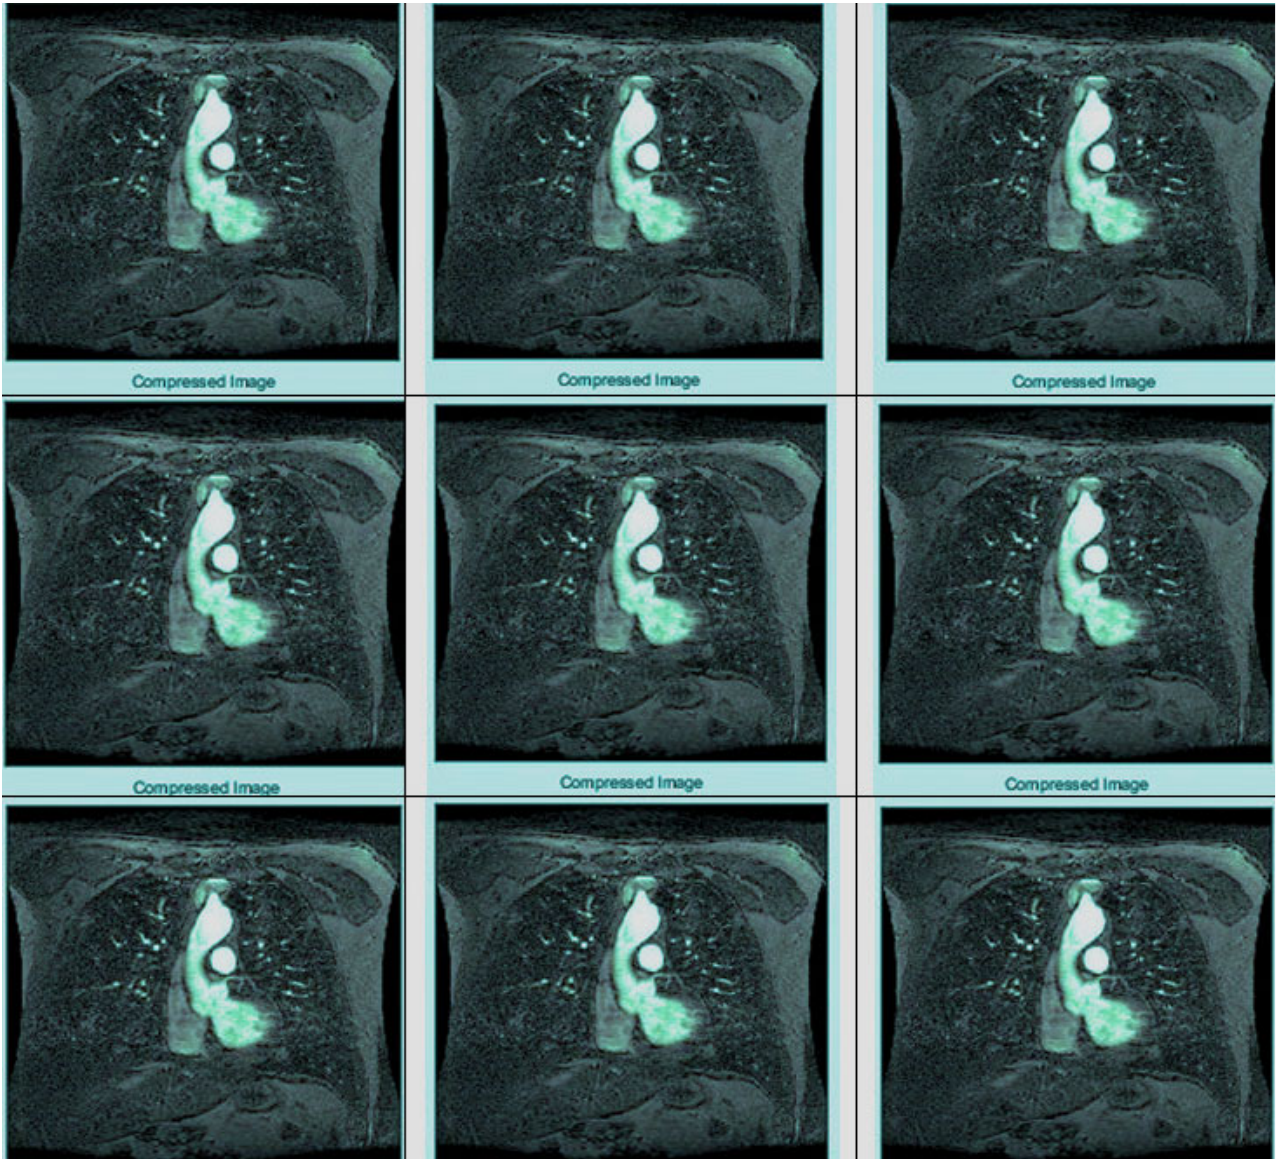
Figure 7. Multiple compression of MRI using different wavelet families.